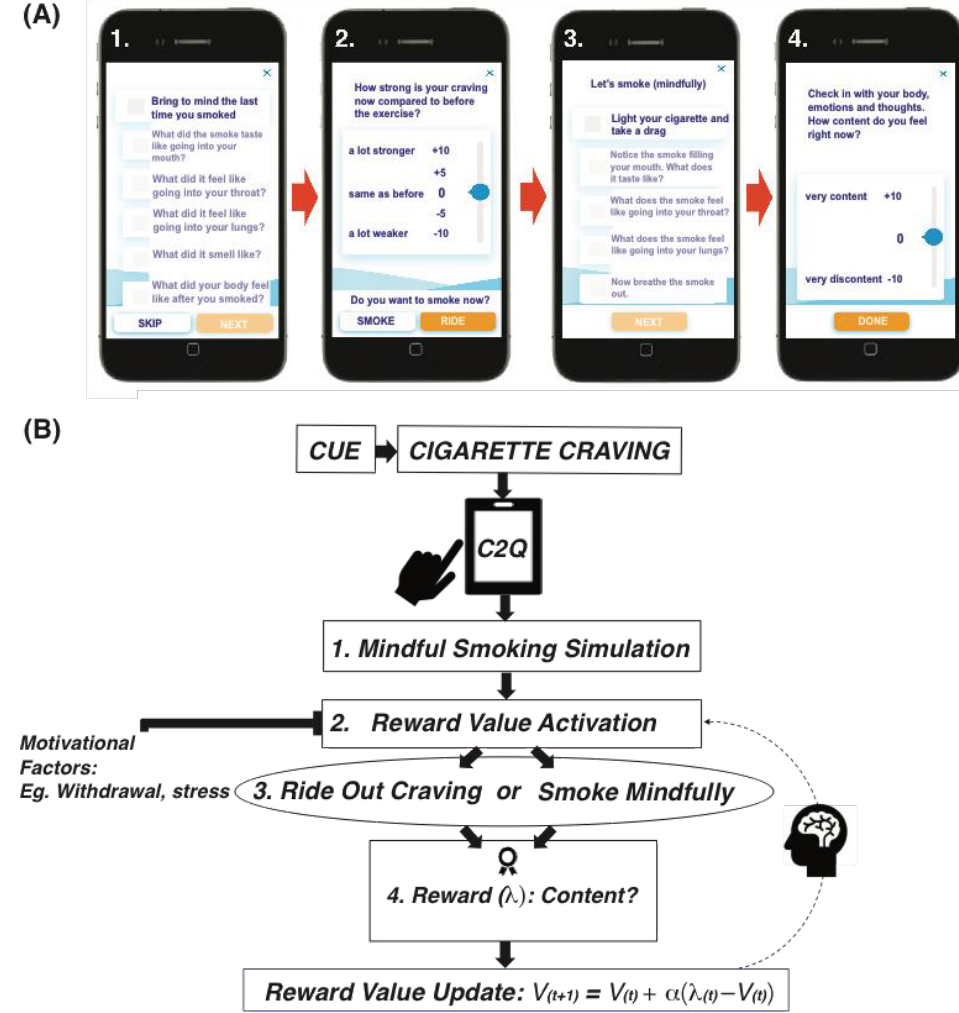
Figure 1. Prototypical craving tool use ( A ) and theoretical model ( B ) depicting the sequence of events/processes involved during the craving tool exercise. C2Q: Craving to Quit mindfulness training program. Expected reward values are denoted as “V” in the equation depicting the Rescorla-Wagner reinforcement learning model used to compute values for each action (smoking or not smoking by riding-out their cravings with the brief informal mindfulness RAIN exercise) at each craving tool use (“t”). Expected values are computed as a function of the prediction error, which is defined as the discrepancy between the outcome (“ λ “: contentment levels after the behavior) and the expected value obtained from the previous craving tool use. The prediction error term is weighed by an individually fixed learning rate parameter (“α“).